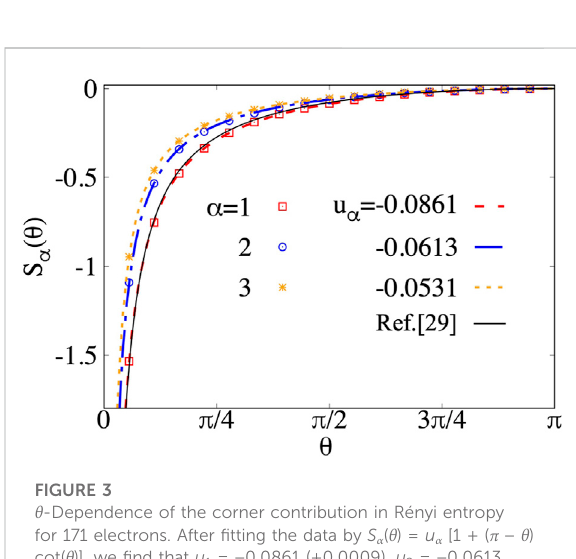
FIGURE 3 θ -Dependence of the corner contribution in Rényi entropy for 171 electrons. After fi tting the data by S α ( θ ) = u α [1 + ( π − θ ) cot( θ )], we fi nd that u 1 = − 0.0861 (±0.0009), u 2 = − 0.0613 (±0.0007) and u 3 = − 0.0531 (±0.0006) which are consistent with the conjecture S α ( θ ) (cid:2) ( 1 + 1 α ) f ( θ )